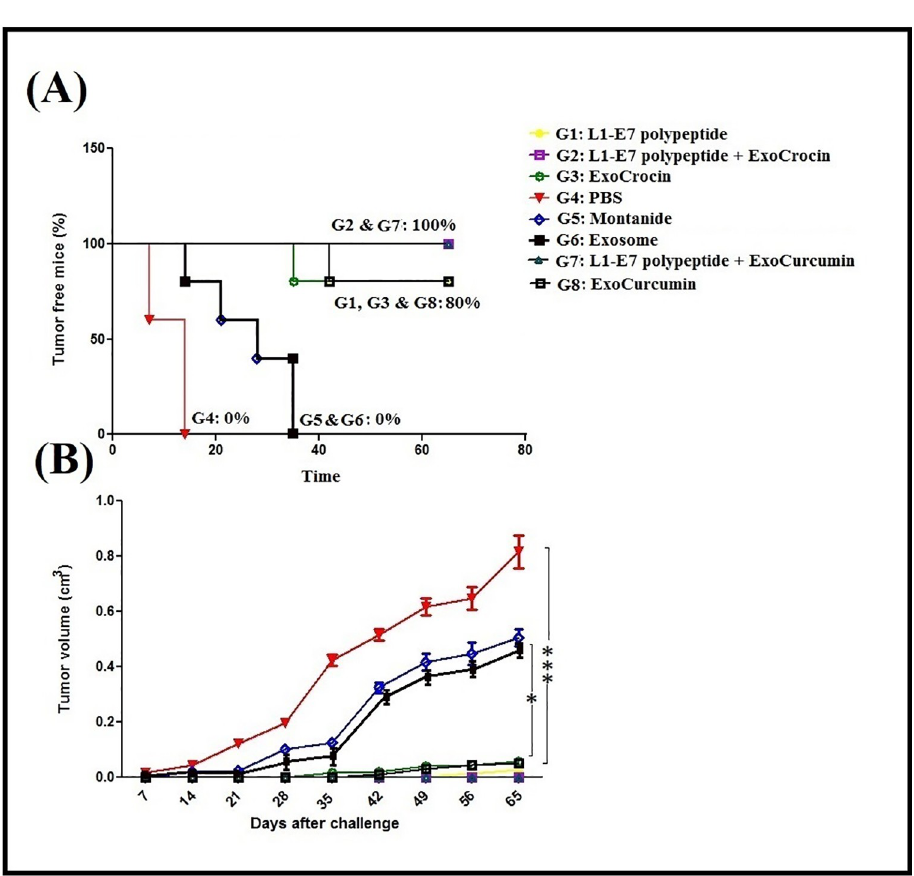
Fig 9. Prevention of tumor growth and survival percentage in immunized groups: (A) The percentage of tumor-free mice in immunized groups; (B) The measurement of tumor volume twice a week; ns: non-significant; � p < 0.05; �� p < 0.01; ��� p <